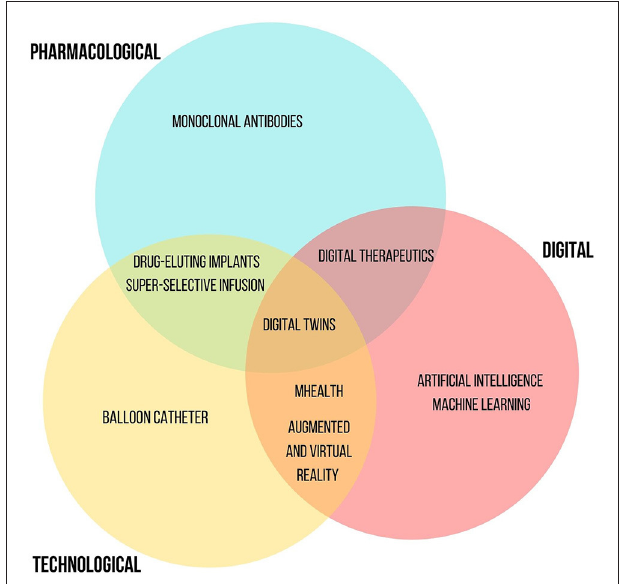
FIGURE 3 | Overlapping nature of each innovative tool in Rhinological